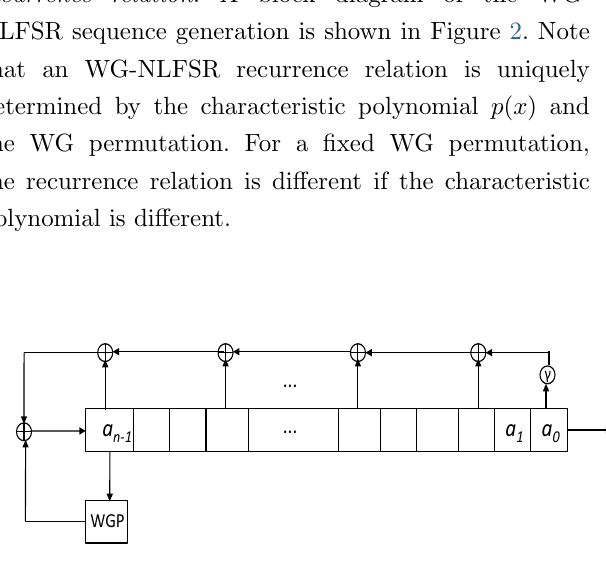
Figure 2. Architecture of the WG-NLFSR Due to the nonlinear term WGP( · ) in the recurrence relation (3), the period of the sequence a is not equal to the period of the polynomial p ( x ). In particular, the period of a depends on three parameters: the characteristic polynomial p ( x ), the WG permutation WGP( x ), and the initial state. To investigate the period of sequence a , we need to study the cycle decomposition of the recurrence